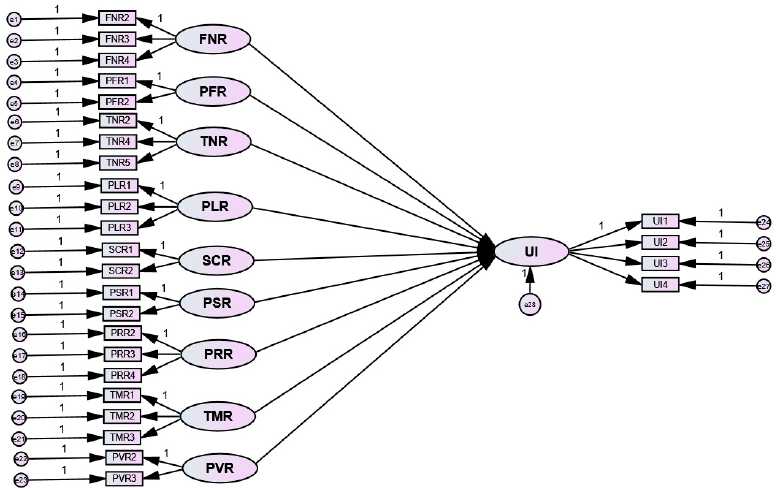
Figure 3. The structural model.